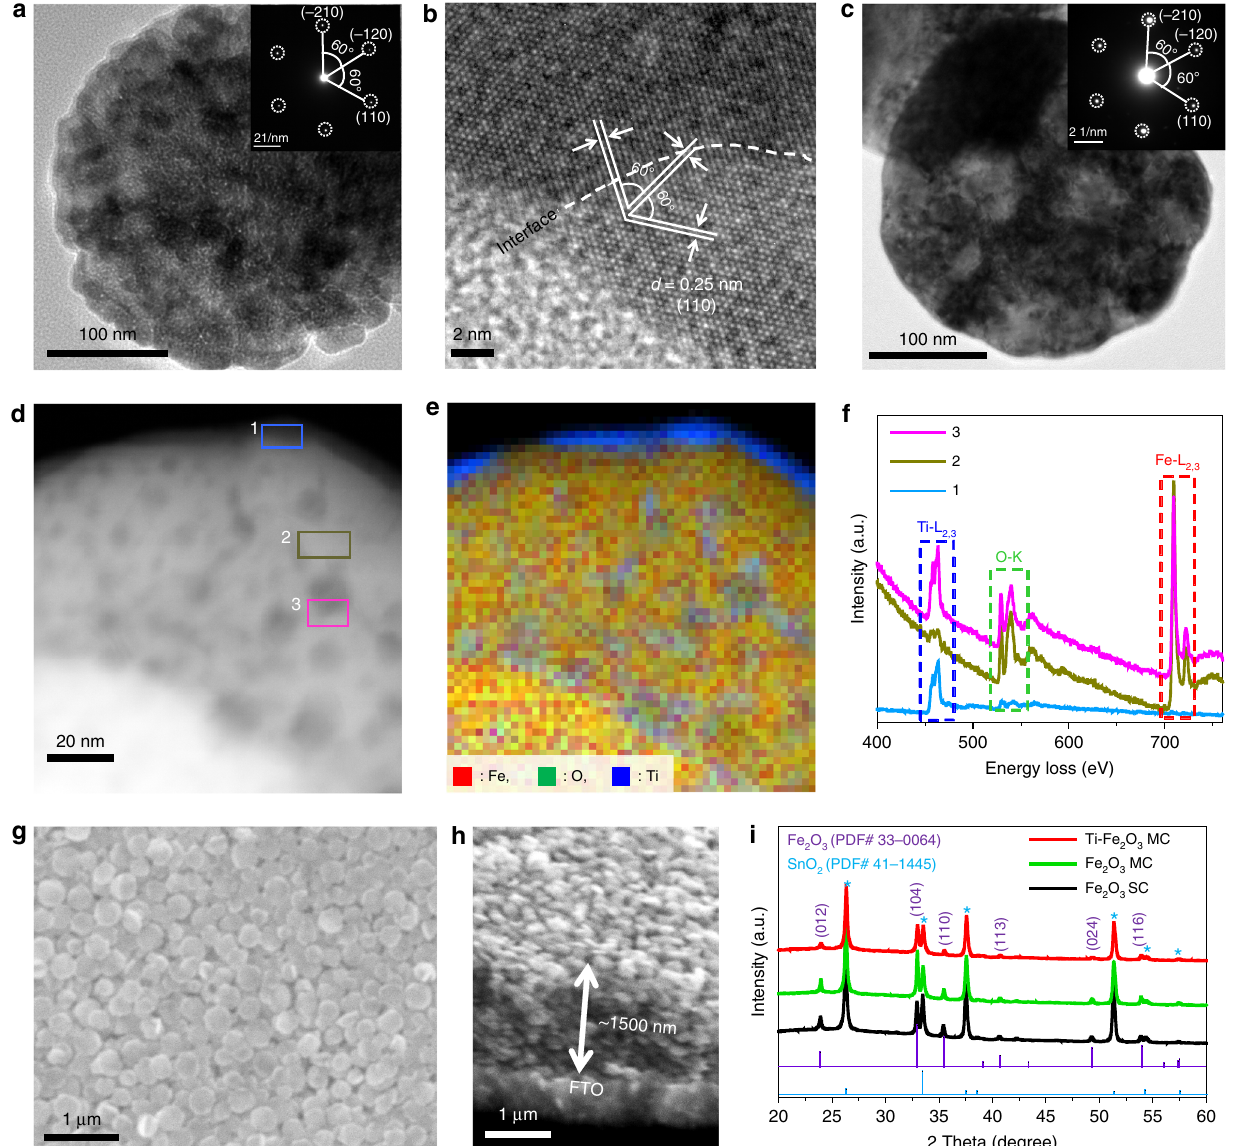
Fig. 1 Morphological characterization of Ti – Fe 2 O 3 MC. a TEM and corresponding SAED (inset), and b HRTEM image of the as-synthesized Ti – Fe 2 O 3 MC. c TEM and corresponding SAED (inset), d HAADF-STEM image and e corresponding EELS chemical composition maps of a typical Ti – Fe 2 O 3 MC particle collected after annealing at 700 °C. f EEL spectra of the selected regions in panel d . g Top-view, and h cross-sectional SEM images of the optimized Ti – Fe 2 O 3 MC photoanode. i XRD patterns of the Ti – Fe 2 O 3 MC, Fe 2 O 3 MC, and Fe 2 O 3 SC